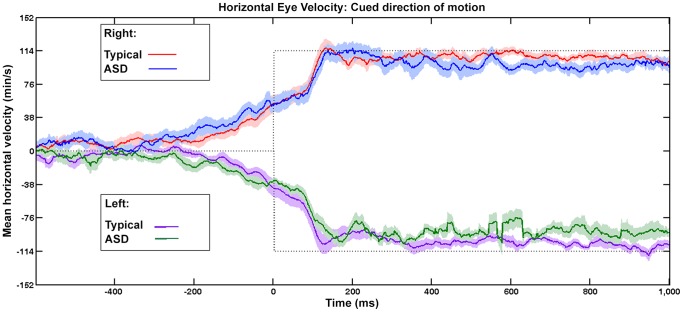
Mean Eye Velocity Over Time, Motion in Cued Directions.Mean horizontal eye velocity (average of participant means) when the visual barrier cue indicated the future path of the moving disc (left or right), for ASD (blue and green lines) and typical (red and purple lines) participants. The dotted line indicates the horizontal velocity of the disc. The disc entered the oblique branch at time  = 0 and traveled either to the right (positive values) or left (negative values) Shading indicates +/− Standard Error.